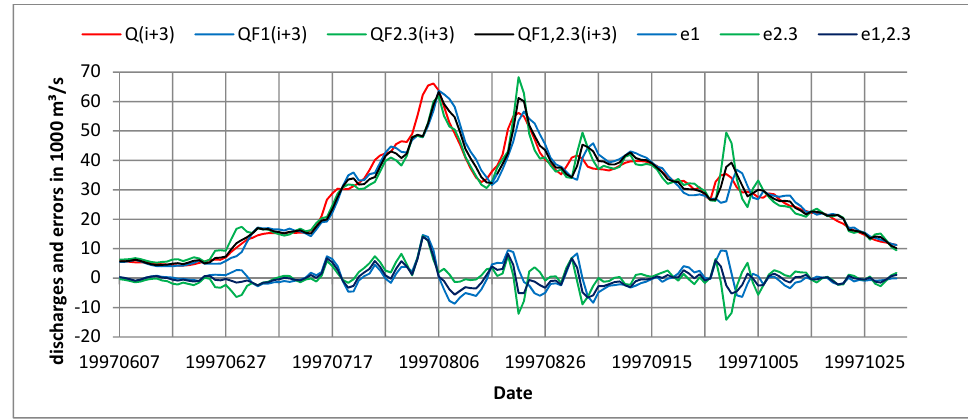
Figure 4. Forecast results for m = 3 days showing model 1, model 2 type 3, and linear combination of the two models to yield model 1,2.3 for Stung Treng in 1997.